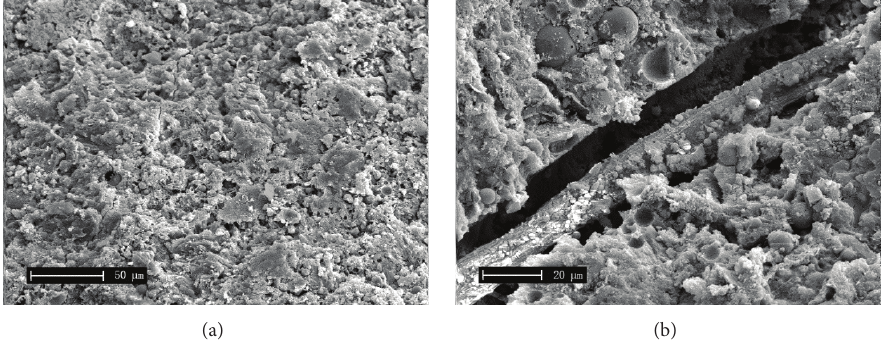
Figure 5: SEM images of microstructure of CFRC exposed at 300 ∘ C for 2.5 h at (a) 1000x and (b) 2000x